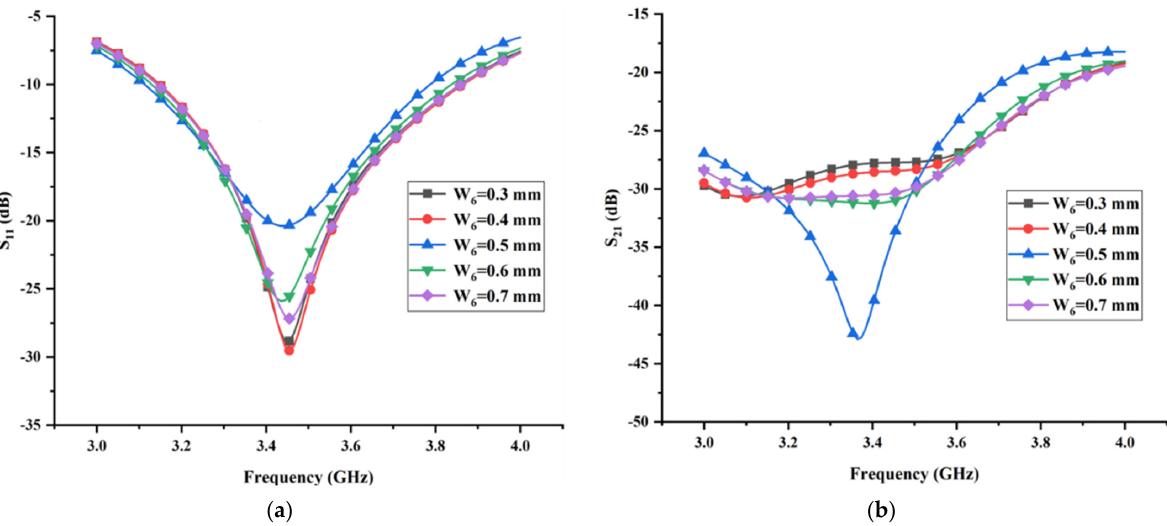
Figure 15. The effects of the width W 6 of the thin horizontal stub on ( a ) reflection coefficient and ( b ) transmission coefficient.